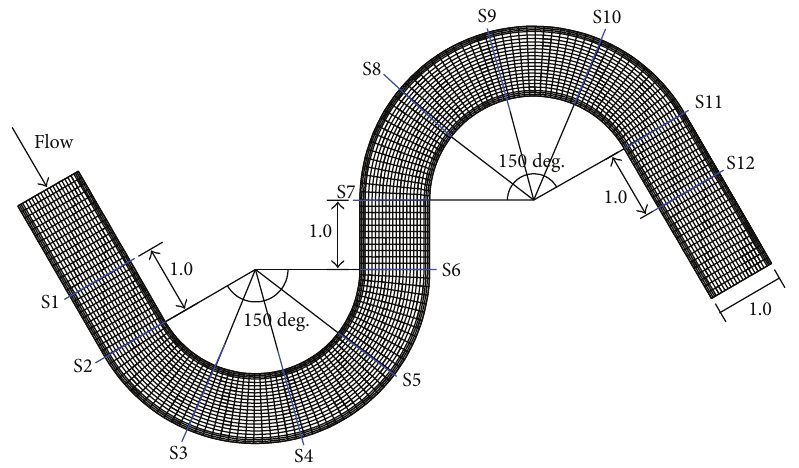
Figure 1: Mesh layout and measured sections for the simulation of the meandering channel (unit: m).